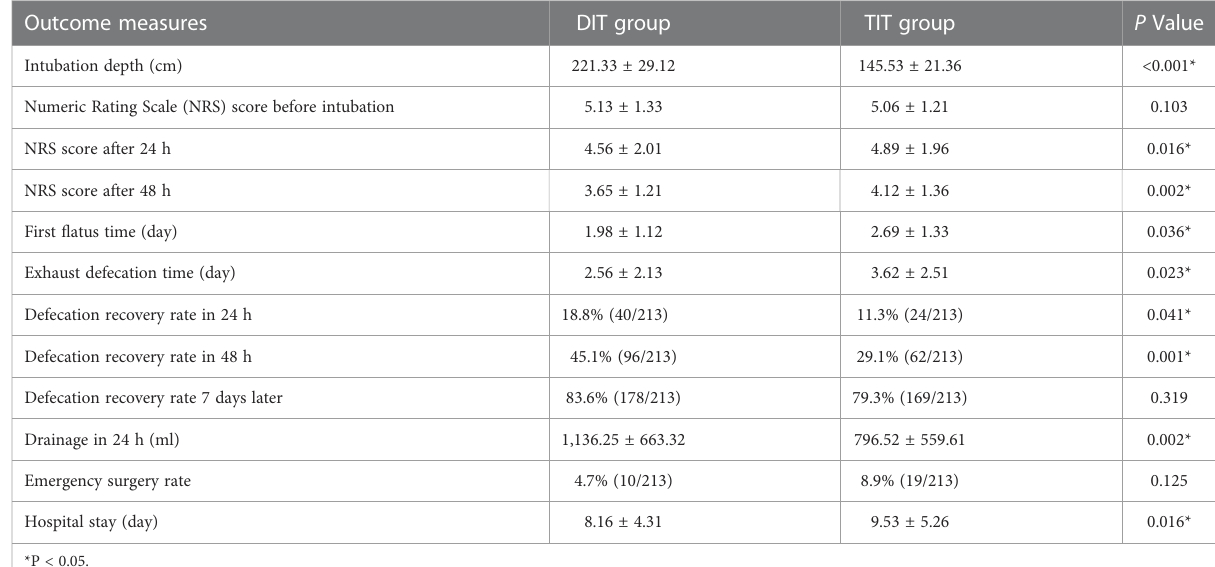
TABLE 2 Short-term outcomes of the deeper intubation technique (DIT) group and the traditional intubation technique (TIT)